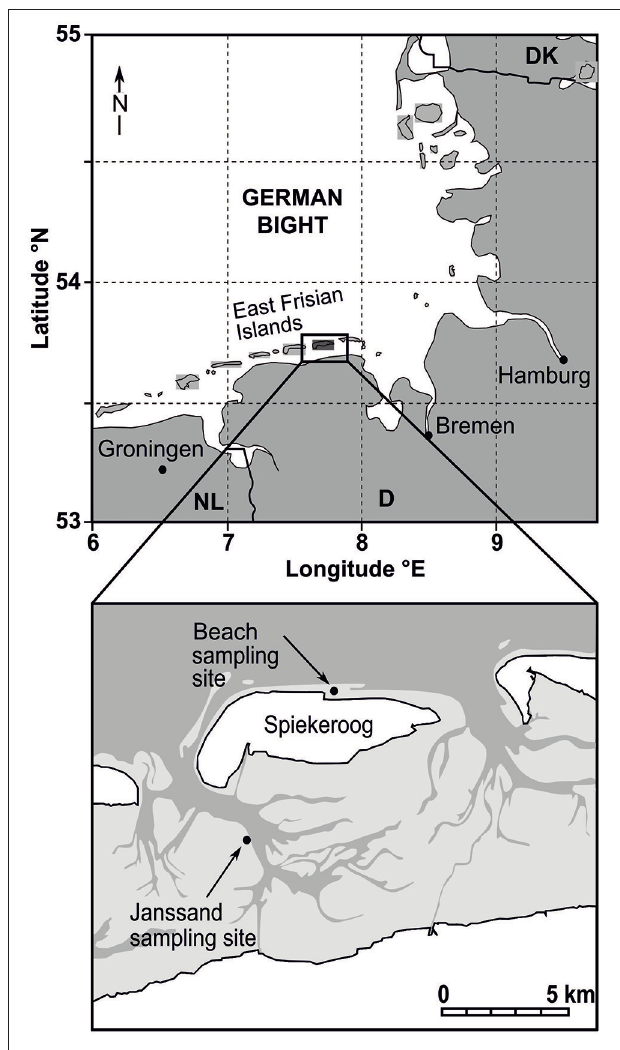
FIGURE 1 | Map of sampling sites beach of Spiekeroog island and Janssand tidal flat adapted from Beck et al. (2017).